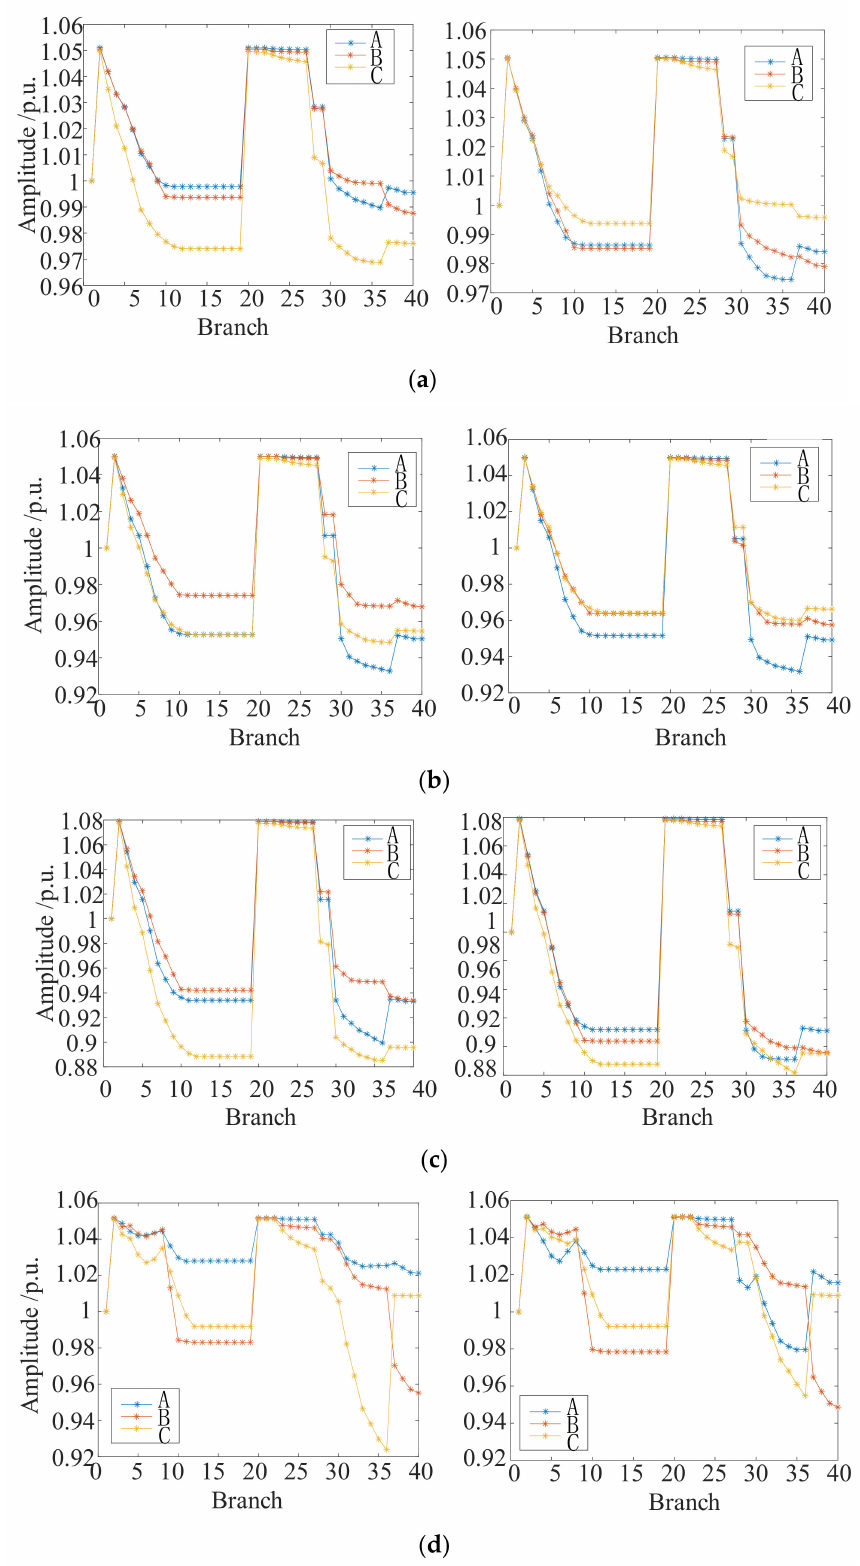
Figure 10. Voltage distribution of each node under different penetration rates. ( a ) Voltage distribution before and after optimization under penetration rate 20%. ( b ) Voltage distribution before and after optimization under penetration rate 40%. ( c ) Voltage distribution before and after optimization under penetration rate 60%. ( d ) Voltage distribution before and after optimization under penetration rate